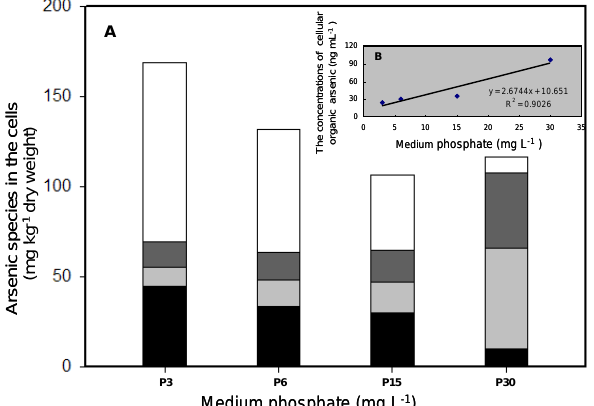
Figure 4. Distribution of As species in the cell after 20 h As(V) exposure under various P levels. ( A ) Concentrations of four arsenic species. Black: As(III); dark gray: dimethylarsenate (DMAs(V)); gray: monomethylarsenate (MMAs(V)); white: As(V); ( B ) The relationship between intracellular organic As concentrations and the initial P levels. All data are the means ± SE ( n = 4).